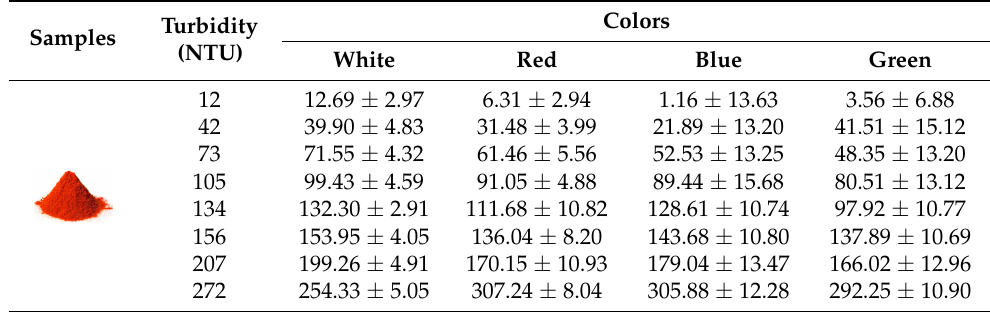
Table 9. The estimated turbidity of the extra concentration samples with the proposed method. It shows mean values ± standard deviation of the turbidity estimated by the CNN and the MLR for each color dataset for paprika